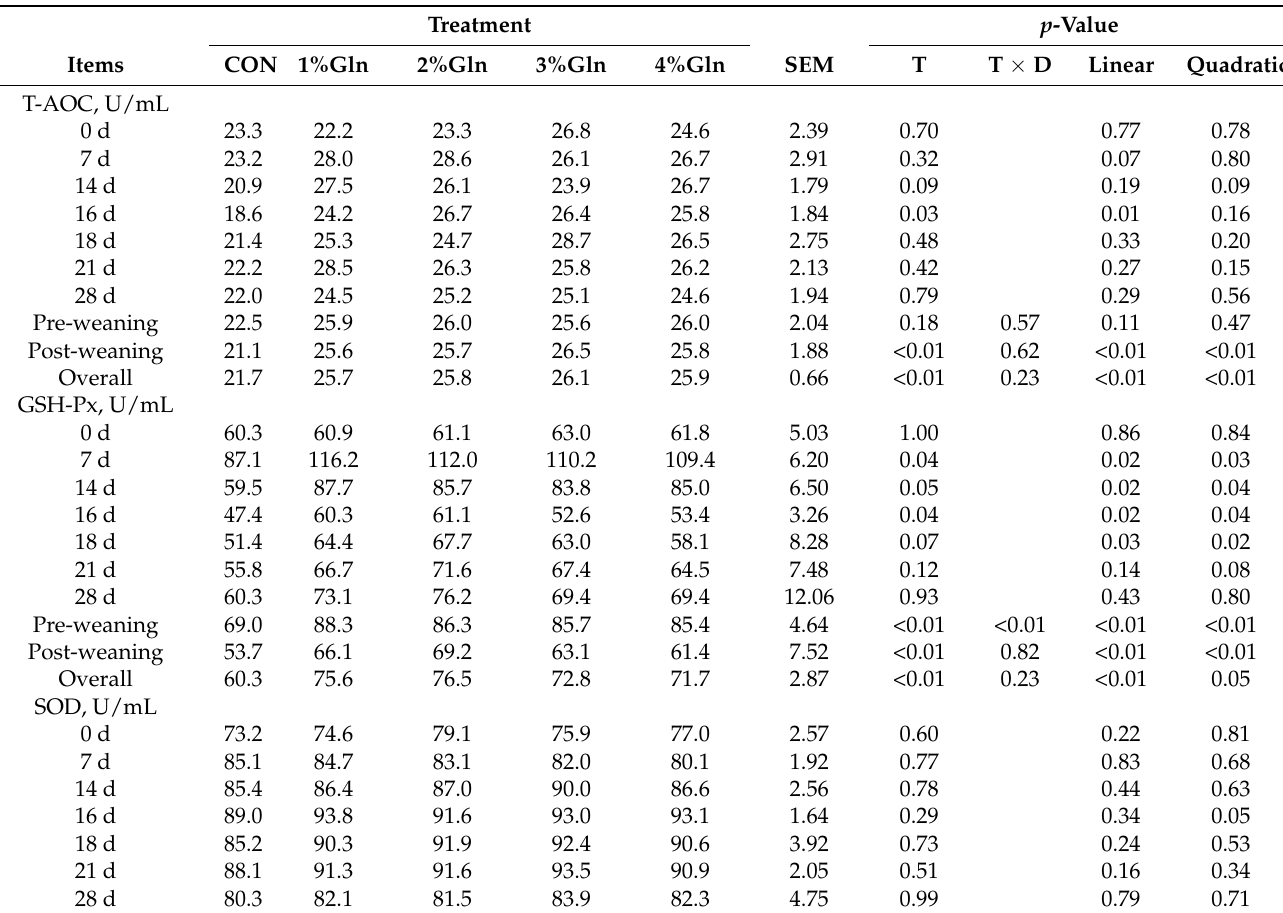
Table 4. Serum antioxidant indicators of calves among different groups (N = 9 per group).